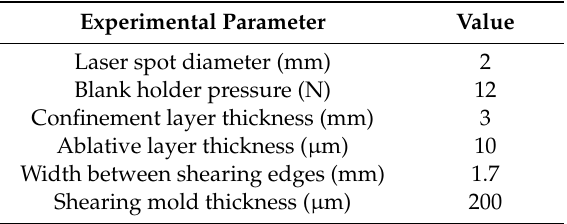
Table 2. Constant experimental parameters in micro-shear clinching.